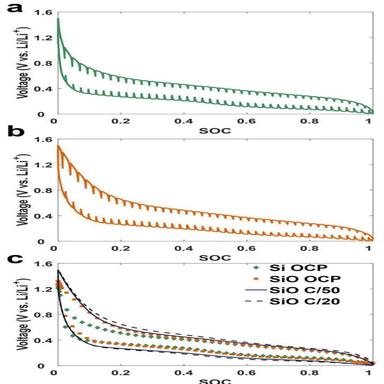
(a) GITT profile for Si half-cell, (b) GITT profile for SiO half-cell, and (c) comparison between OCPs and dynamic voltage profiles recorded at low C-rates (C/20 and C/50).